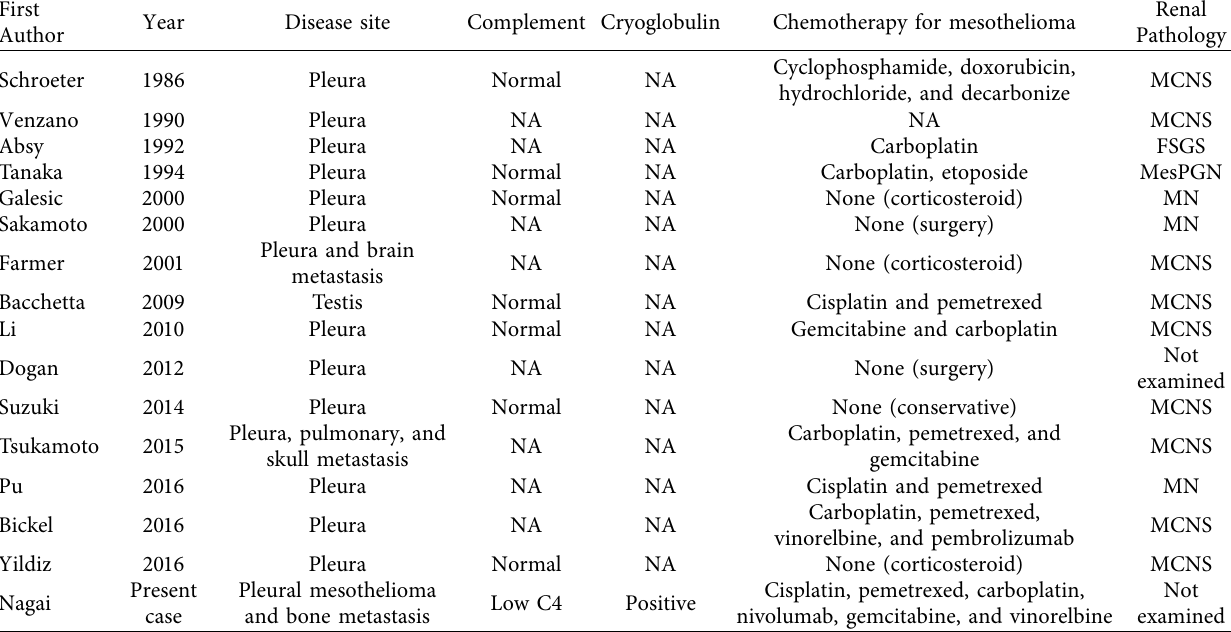
Table 2: The literature review of cryoglobulin and renal diseases in malignant